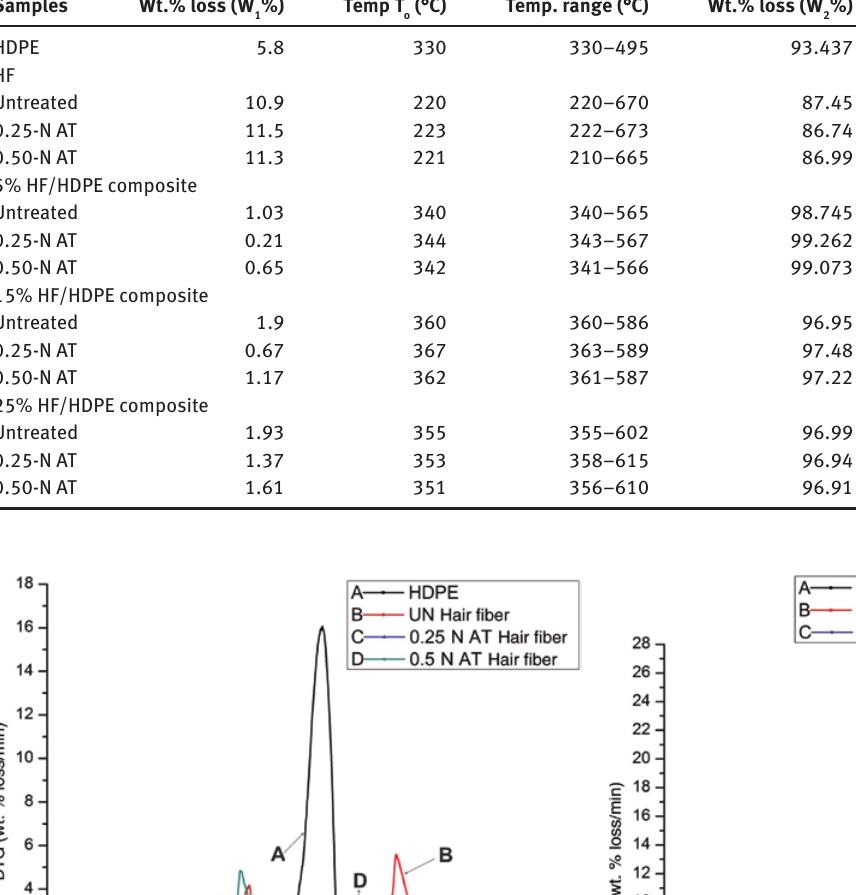
Table 1: Degradation temperature obtained from TGA thermograms. Samples